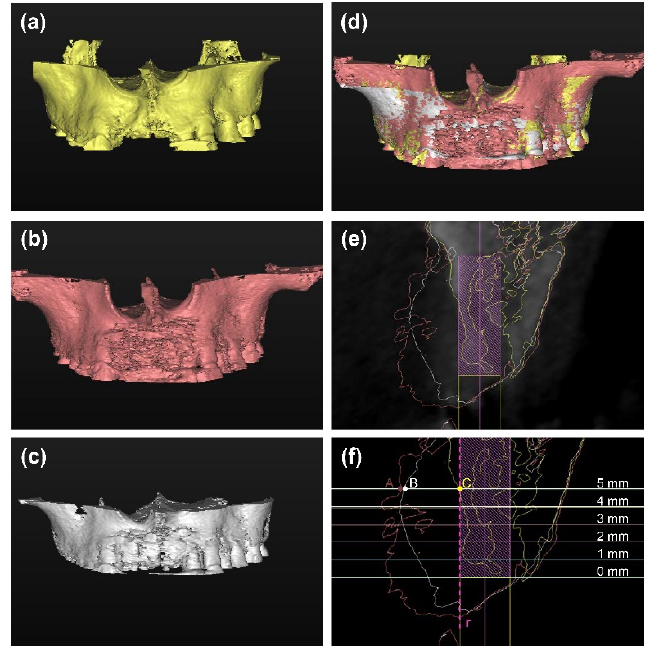
Figure 4. ( a – d ) The DICOM files of the postoperative CBCT scans at T1 (( b ), red) and T2 (( c ), white) were converted to STL files, respectively, and superimposed on the preoperative CBCT (( a ), yellow). ( e ) The bucco-oral cross-sectional image perpendicular to the virtual implant was used for measure- ments. Yellow line: the outline of the hard tissue before surgery (T0); red line: the outline of the hard tissue after wound closure (T1); white line: the outline of the hard tissue at 6 months (T2). ( f ) The labial thickness of the hard tissue (LT) was measured at the implant shoulder (LT 0 ) and 1, 2, 3, 4 and 5 mm (LT 1 –LT 5 ) apical to the implant shoulder at each time point. The labial outline of the virtual implant was drawn as a reference line “r”. Six lines perpendicular to line “r” at different levels were labially intersected with the 3 outlines (eg, at level LT5, the distance from point “A”, “B”, “C” to line “r” was LT at T1, T2, T3, respectively). The LT was labeled as “0” when the outline of the hard tissue was in the palatal side of the line “r”.